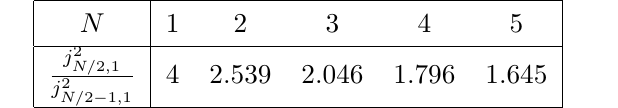
Table 2 . Approximate values for the maximum ratios of Dirichlet eigenvalues for some N - dimensional balls in Euclidean